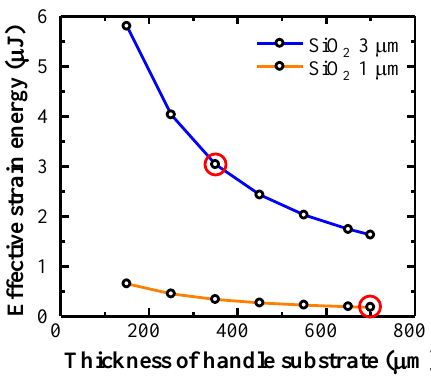
Figure 7. Analysis of effective internal strain energy of bonded silicon-on-insulator (SOI)/SOI structure. Red circles indicate the condition used in the experiment in Figures 8 and 10.